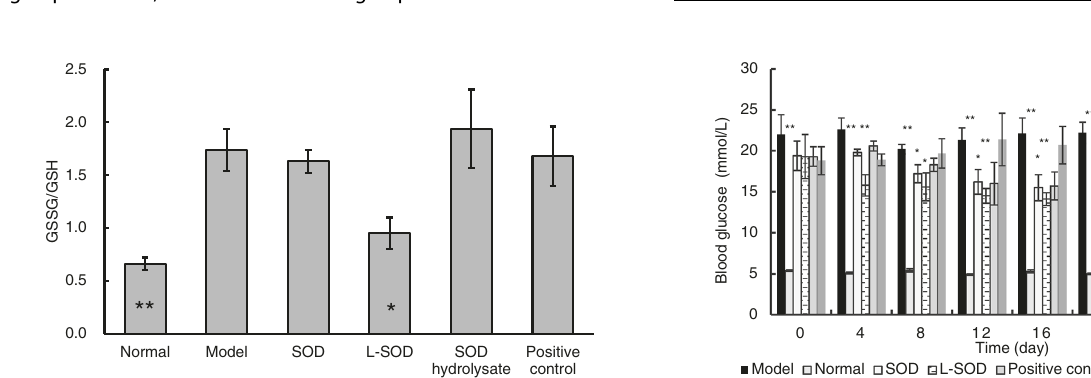
Fig. 1 MDA content in the colons of T2D model rats after 4-week intervention. The data are presented as mean ± SD, n = 6 each group. * P < 0.05, ** P < 0.01 vs. model group.